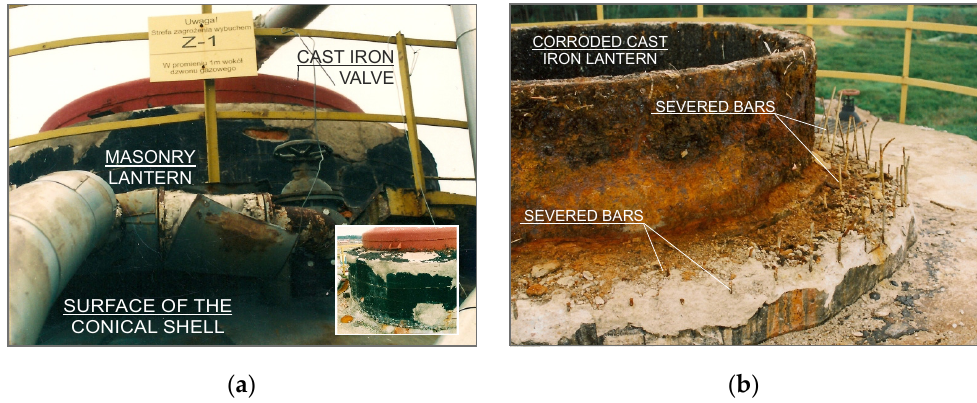
Figure 4. Degraded zones of fermentation chamber roofing shell: ( a ) before explosion; ( b ) after explosion.